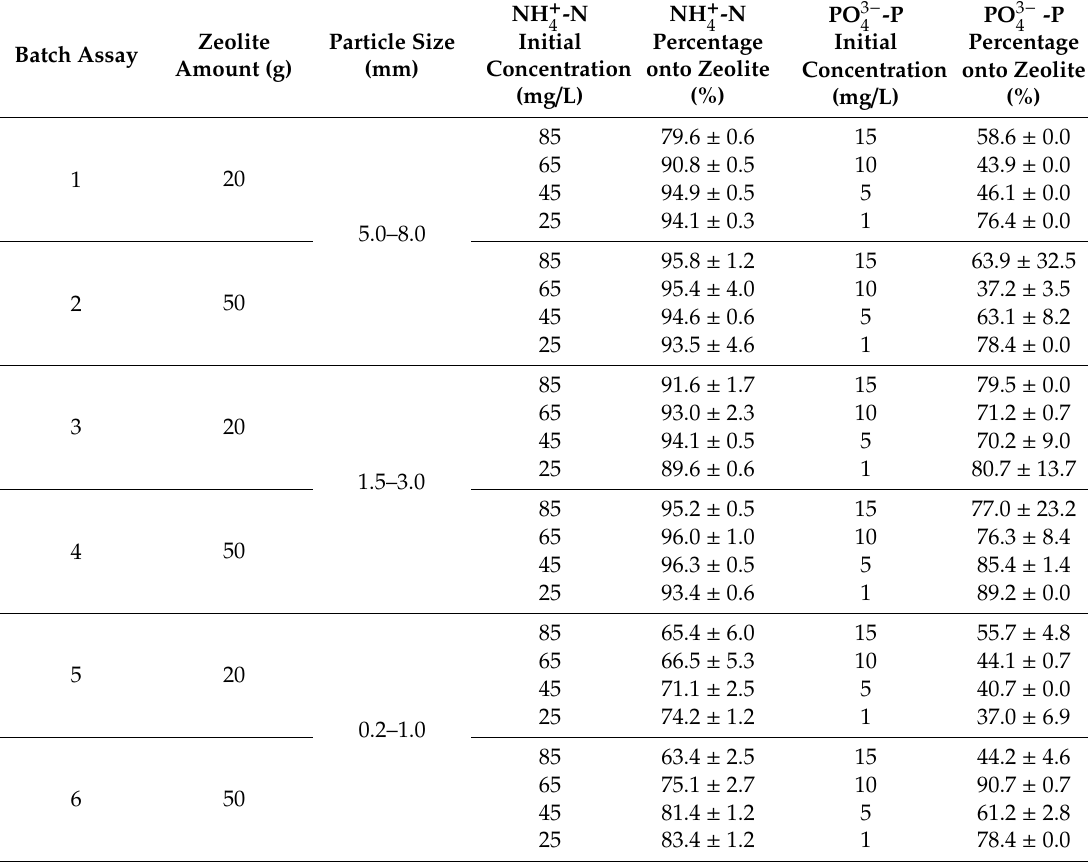
Table 4. Percentage of NH + determination of adsorption characteristics (average ± standard